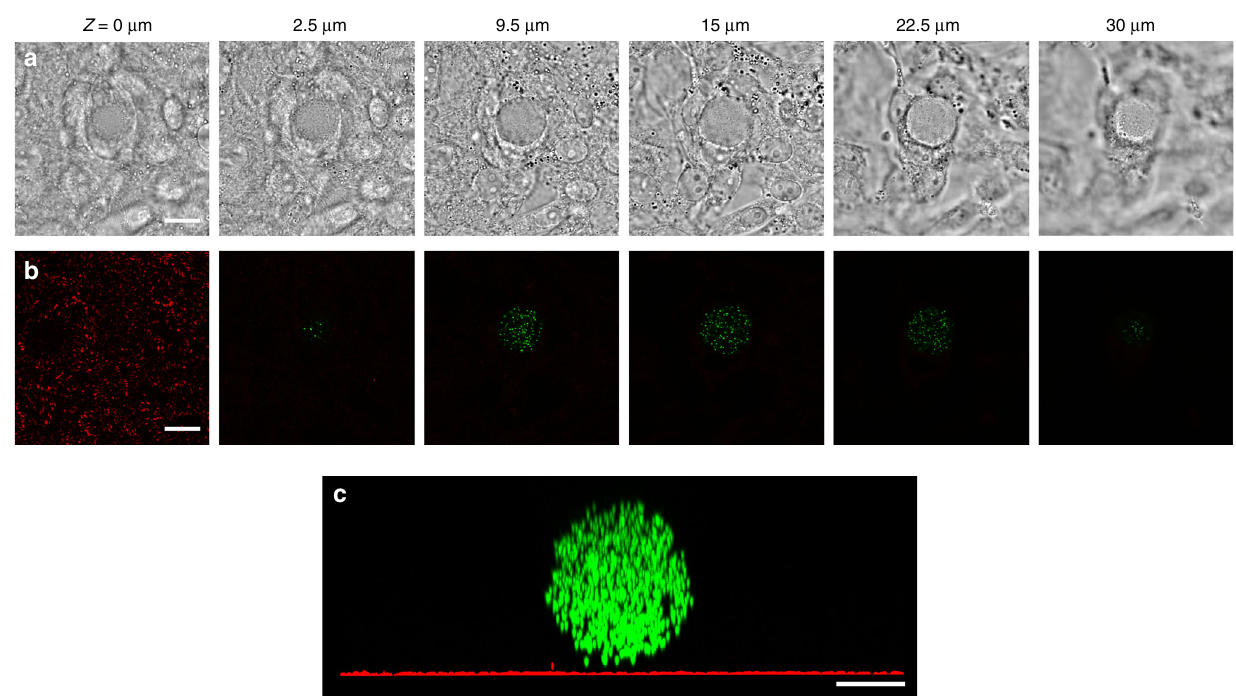
Fig. 4 No mature focal adhesions are observed near a microgel in multilayered cells. a Representative bright fi eld confocal sections of the embedded microgel in multilayered cells. b Corresponding images of paxillin (red) and of the microgel (green). Focal adhesions are visible only at the bottom of the cell layer on top of the glass. Scale bars, 15 µ m. c Y – Z projection of the 3D confocal fl uorescent images of the microgel (green) and paxillin (red) shows that no mature focal adhesions or focal complexes are around the microgel. Scale bar, 10 µ